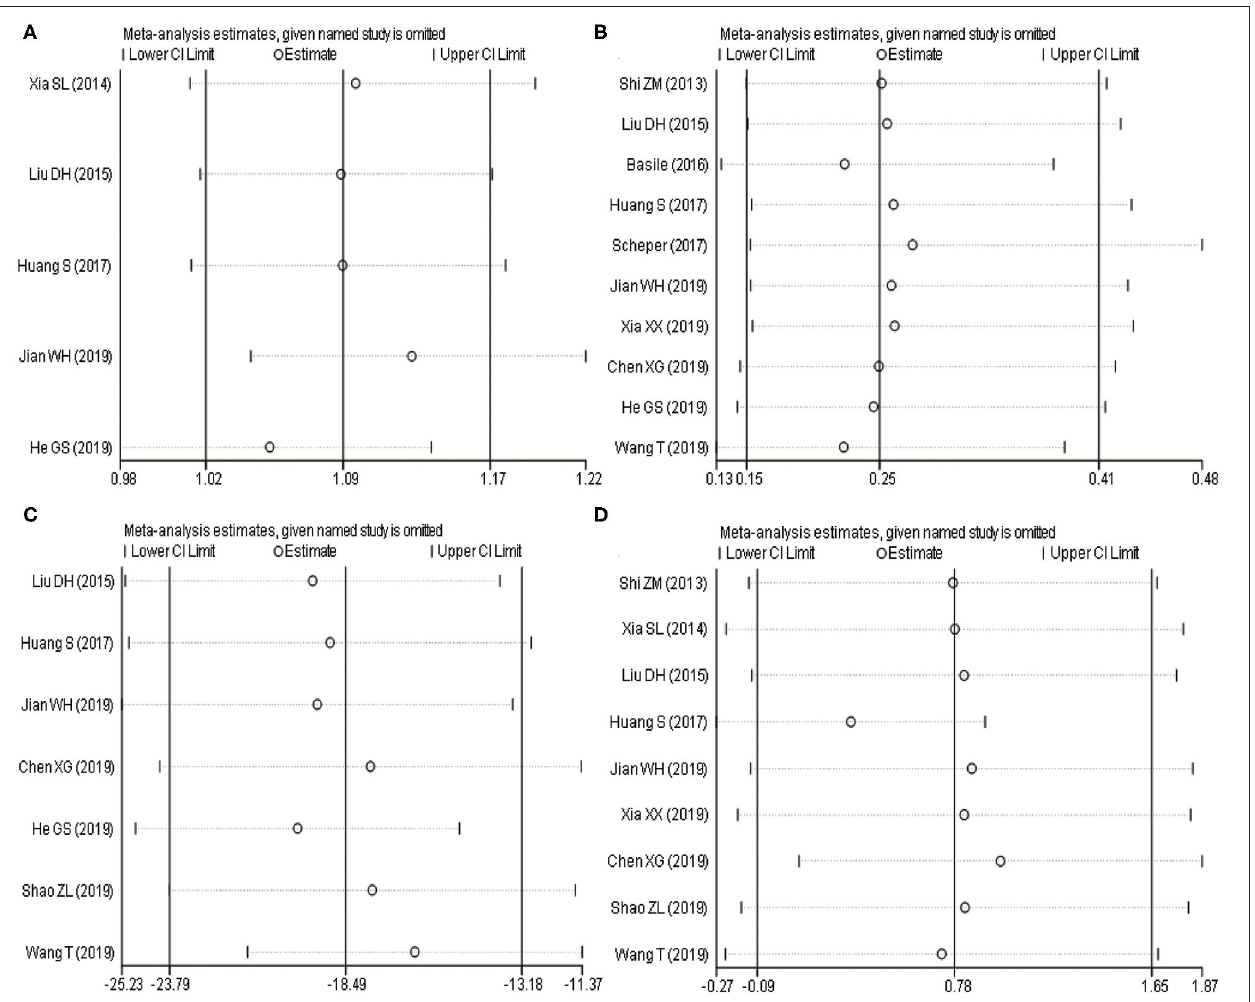
FIGURE 5 | Sensitivity analysis of two surgical procedures with associated outcome indicators ( A : excellent and good rate of Maryland foot function; B : postoperative complications; C : intraoperative blood loss; D : Böhler angle). (A,B) Horizontal line shows relative ratio; (C,D) Horizontal line shows mean